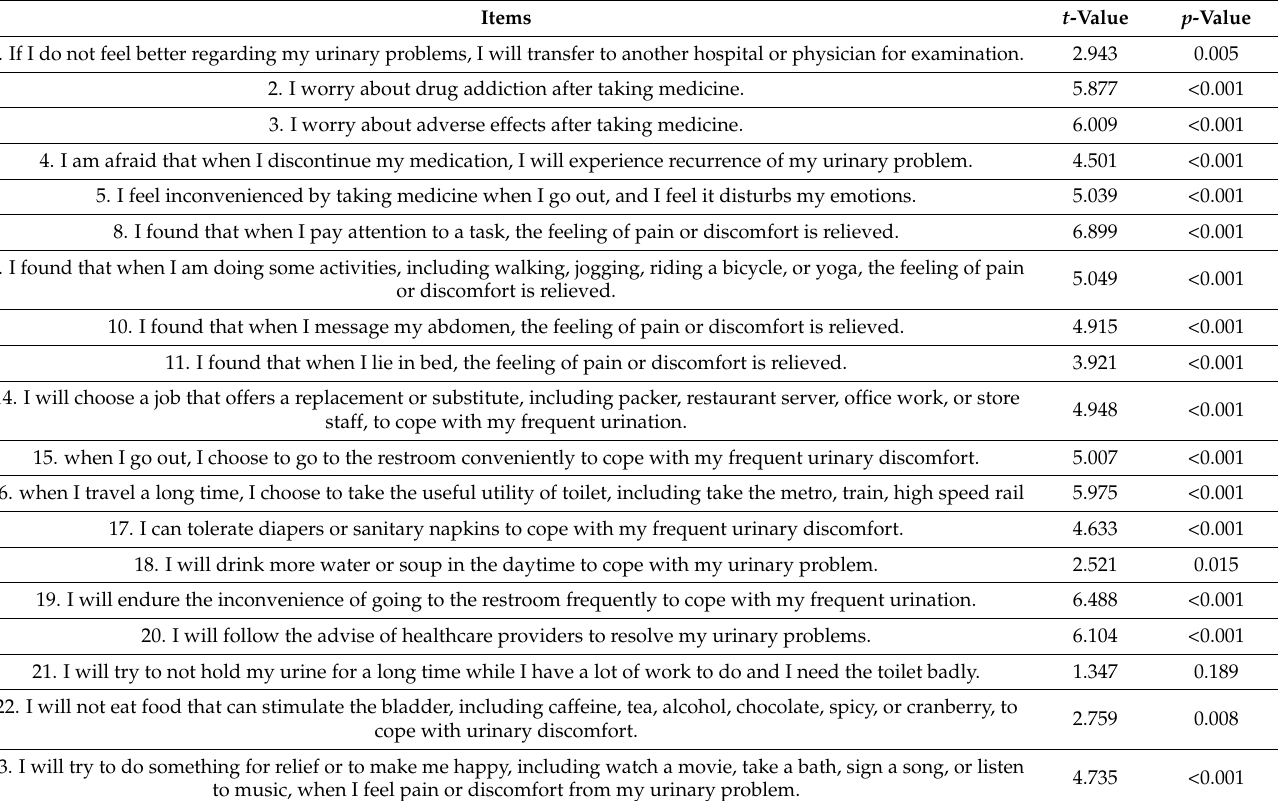
Table 4. Comparisons of the high- and low-scoring groups in the ICSR ( N = 100). Items t -Value p